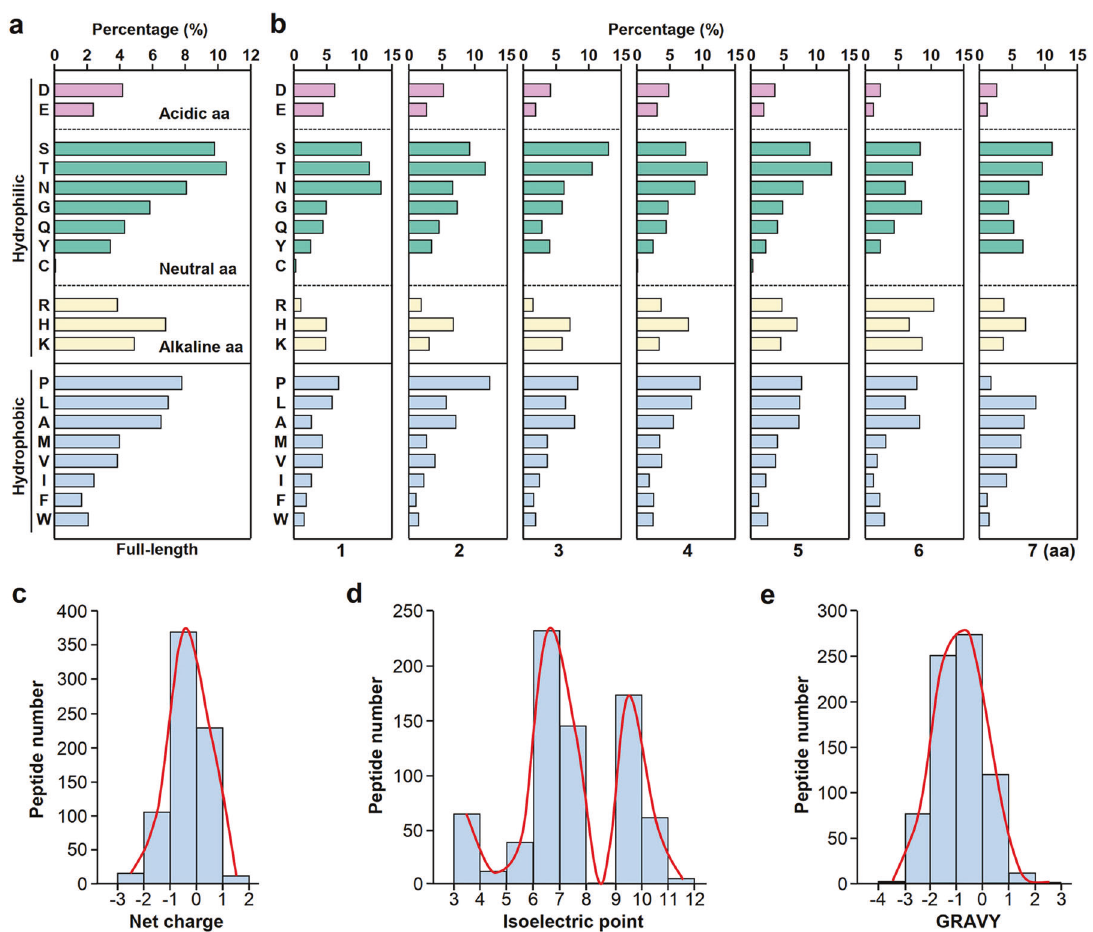
Fig. 4 Physical characteristics of the heptapeptides binding to the lethal bacterial strain MSI001 . a Amino acid (AA) composition of the bacterial binding heptapeptides. According to the physical properties, all 20 AAs were divided into hydrophilic and hydrophobic AAs. There are three kinds of hydrophilic AAs, including 2 acidic AAs, i.e., aspartic acid (D) and glutamic acid (E); 7 neutral AAs, i.e., serine (S), threonine (T), asparagine (N), glycine (G), glutamine (Q), tyrosine (Y) and cystine (C); and 3 alkaline AAs, i.e., arginine (R), histidine (H) and lysine (K). The hydrophilic AAs were proline (P), leucine (L), alanine (A), methionine (M), valine (V), isoleucine (I), phenylalanine (F) and tryptophan (W). b AA composition of the bacterial binding heptapeptides in different positions (AAs 1-7) of the 7-mer peptides. c Statistical analysis of the electrical properties of the bacterial binding heptapeptides. The net charge of each heptapeptide was acquired by online Protein Calculator v3.4 software (http://protcalc.sourceforge.net). d Compositional analysis of the isoelectric point (PI) of the bacterial binding heptapeptides. The PI value of each heptapeptide was acquired by online Protein Isoelectric Point Calculator software (http://www.endmemo.com/bio/proie. php). e The hydropathicity distribution of the bacterial binding heptapeptides. The GRAVY value was predicted online at http://www.gravy-